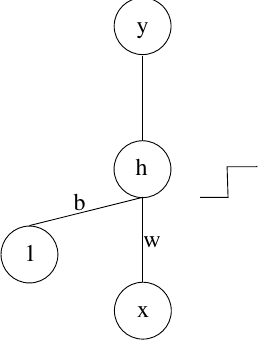
Figure 5. A Discretized Interpretable Multi Layer Perceptron (DIMLP) network that potentially creates a discriminative hyperplane in − b / w . The activation function of the hidden neuron is a step function, while for the output neuron it is a